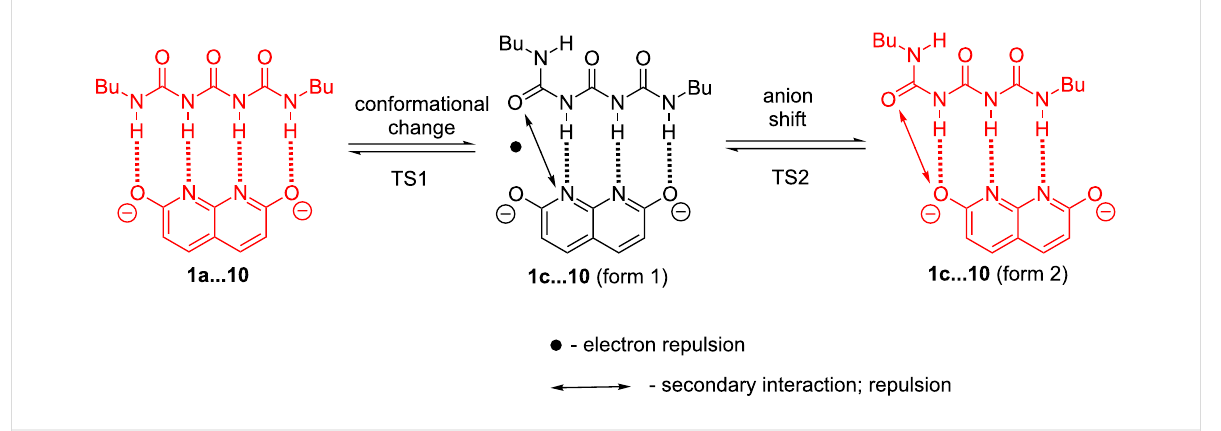
Figure 10: Two most probable forms of 1 ∙∙∙ 10 complex (in red) with "rotational-shift" path between them.